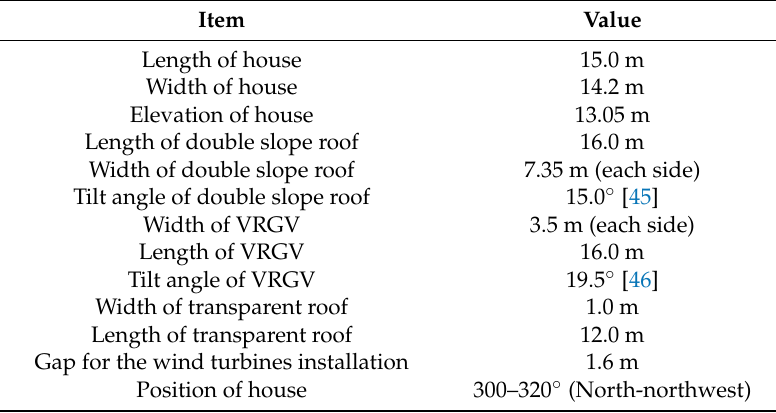
Table 1. General parameters of the